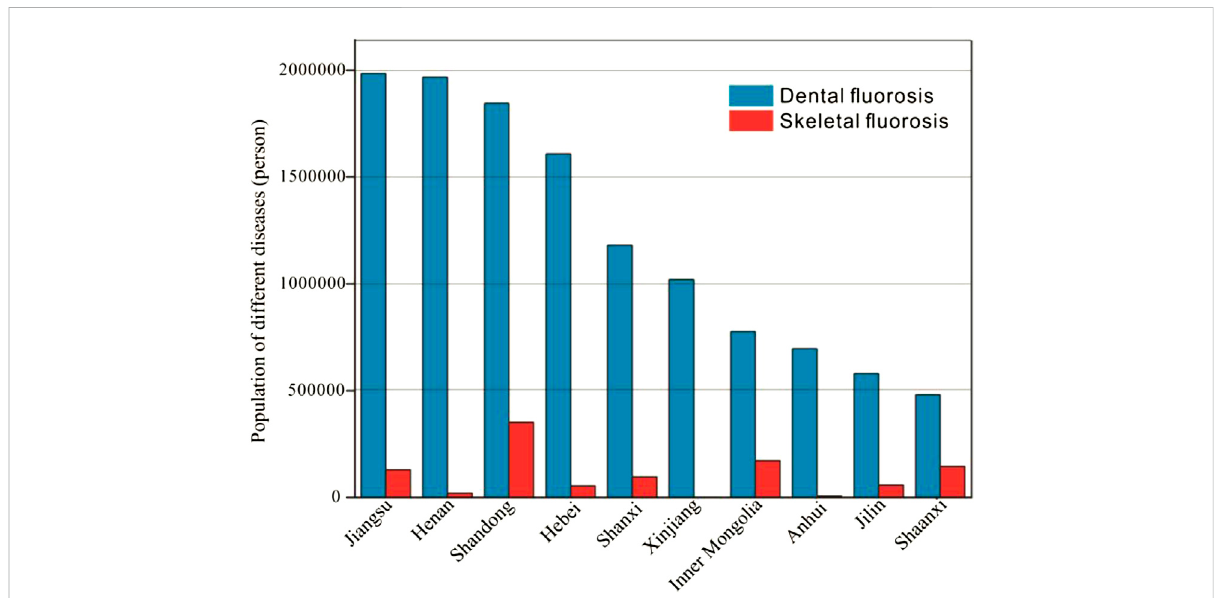
FIGURE 4 Number of patients with dental fl uorosis and skeletal fl uorosis in some provinces and cities in 2017 in